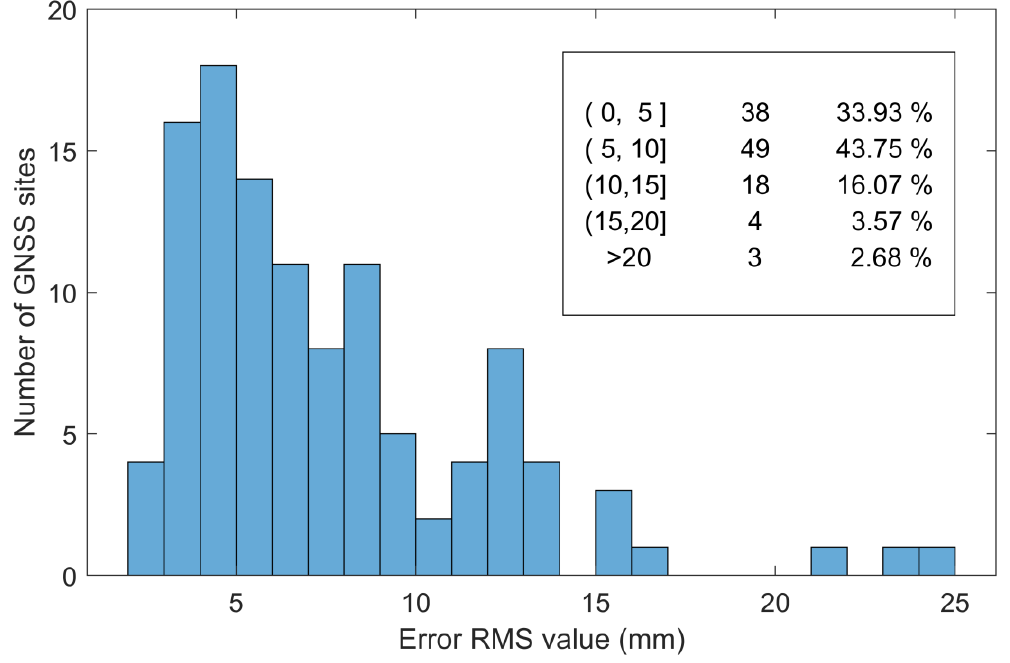
Figure 4. Statistical results of the error RMS value between the GNSS displacement converted to the LOS direction and the GInSAR